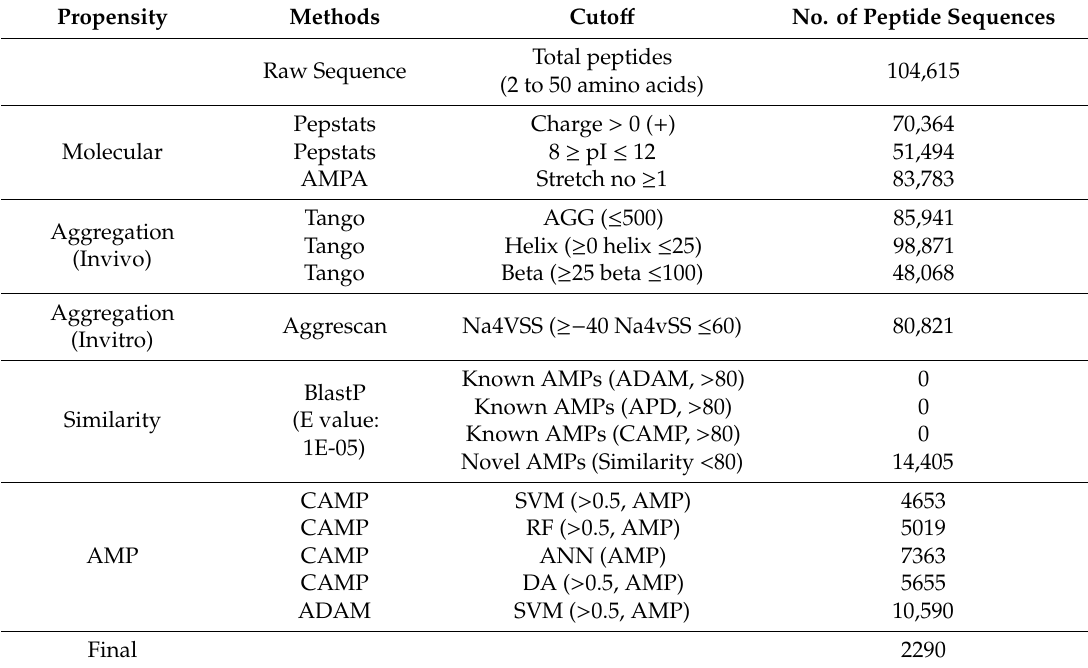
Table 2. Antimicrobial peptide properties prediction and